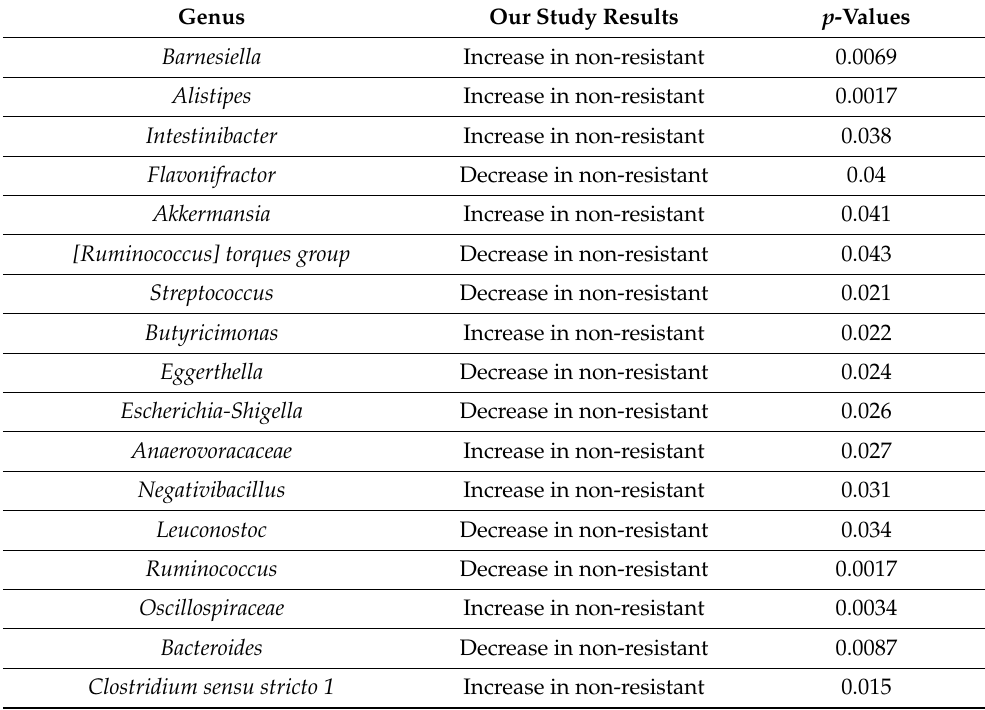
Table 6. Bacterial abundance tendency in the non-resistant